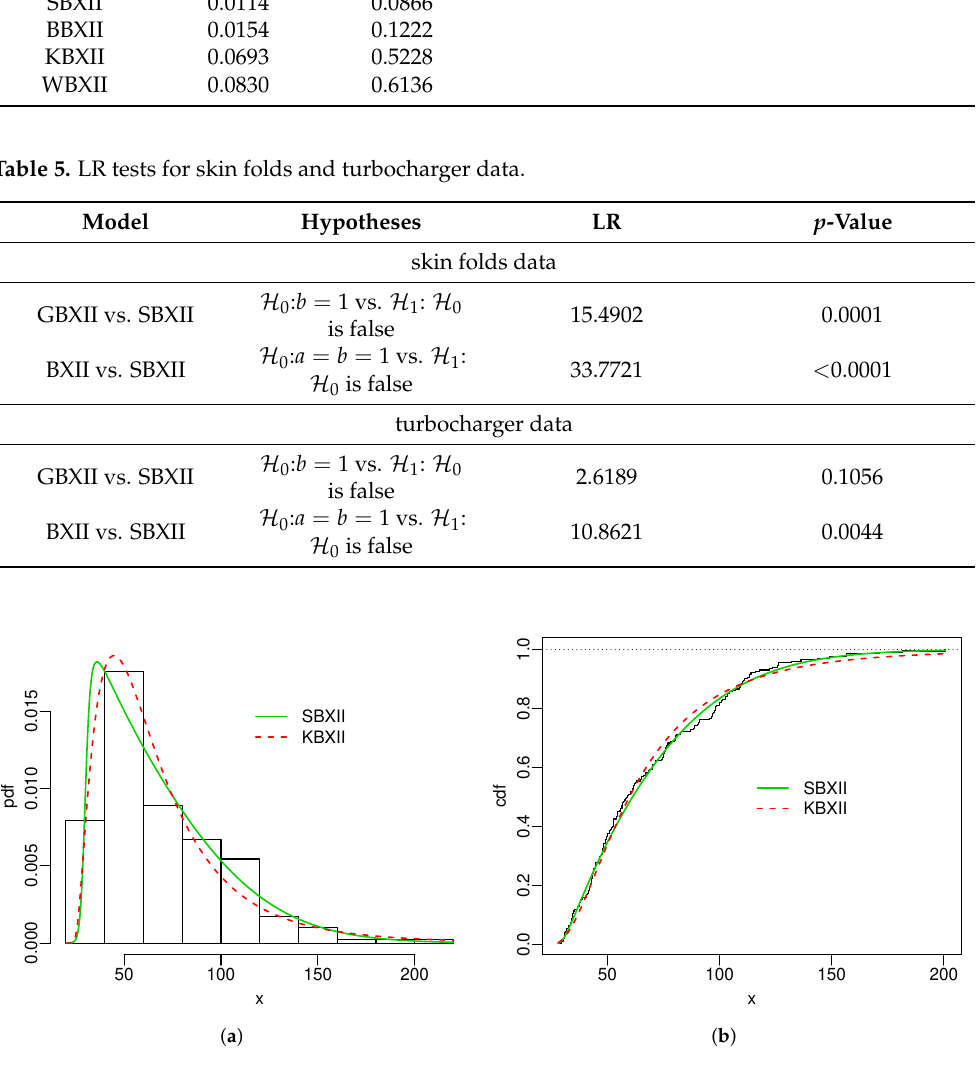
Figure 4. Estimated pdfs ( a ) and estimated cdfs ( b ) for skin folds